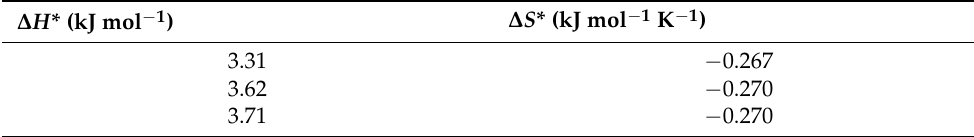
Table 10. Thermodynamic parameters for the transition